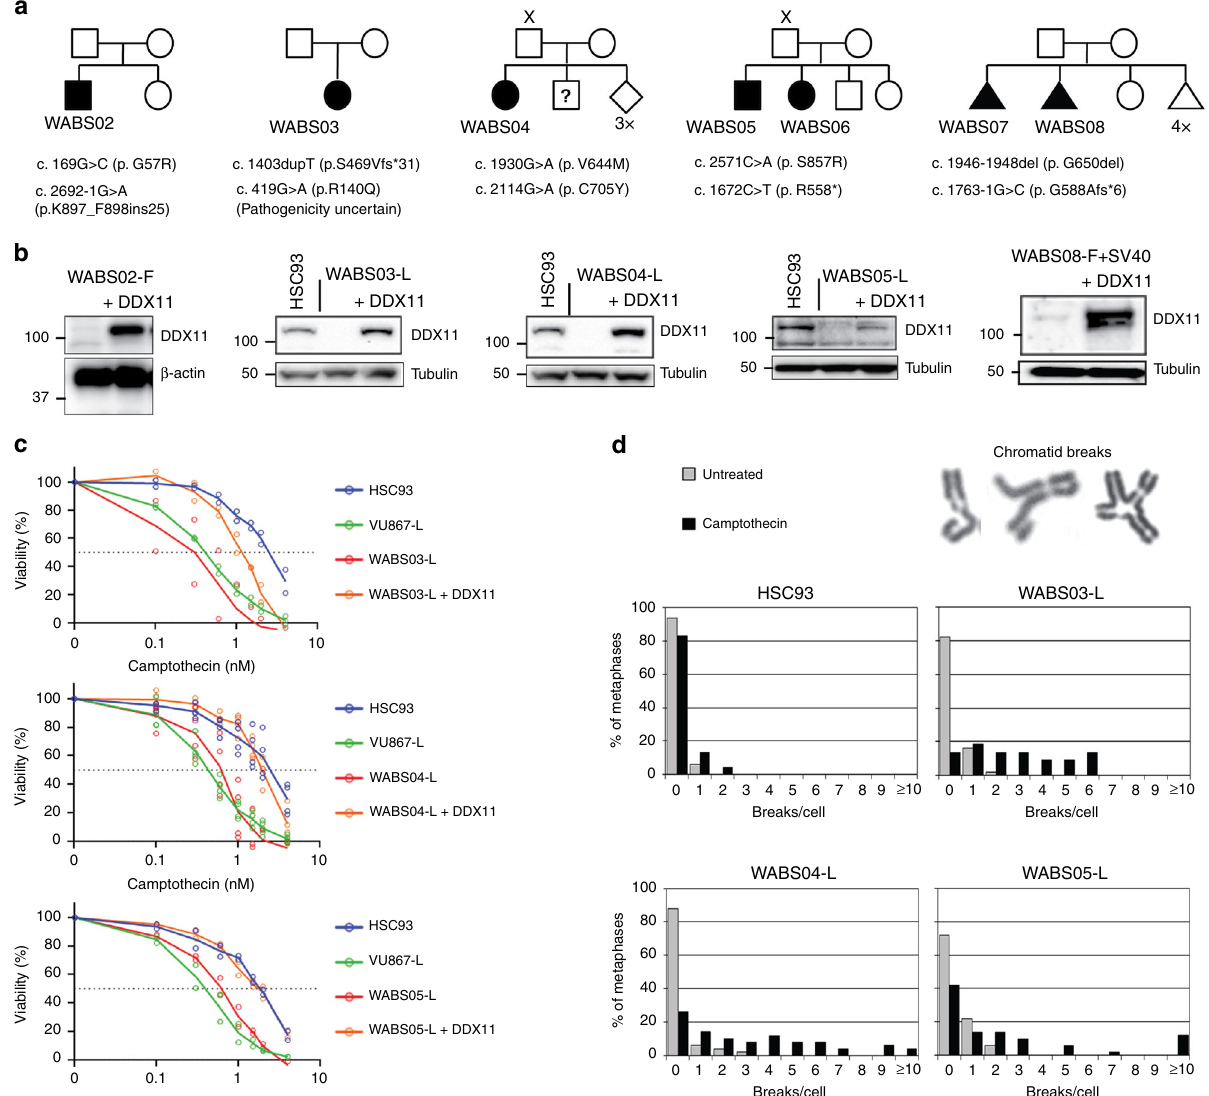
Fig. 1 Identi fi cation of multiple new Warsaw Breakage Syndrome (WABS) cases. a Pedigrees of seven new WABS patients. X indicates absence of paternal DNA; question mark indicates uncertain whether patient has WABS; diamond indicates unknown sex; triangle indicates fetus. Nomenclature is based on DDX11 transcript variant NM_030653.4. b Western blots of patient-derived lymphoblasts (L) and fi broblasts (F). DDX11 protein levels were restored by stable transfection of DDX11 cDNA. Examples of two independent protein analyses are shown. c Wild-type lymphoblasts HSC93, FANCM- de fi cient lymphoblasts VU867-L 80 , three WABS-derived lymphoblasts and their complemented counterparts were continuously exposed to increasing Camptothecin concentrations, in two or three independent experiments. After three population doublings of untreated cells, cells were counted and plotted as percentage of untreated cells. d metaphase spreads of cells treated as in ( c ) were assessed for chromosome breaks, n = 50 for each condition. Depicted examples of counted aberrations include a chromatid gap, a dislocated broken piece and a chromatid interchange fi gure ( ‘ triradial ’